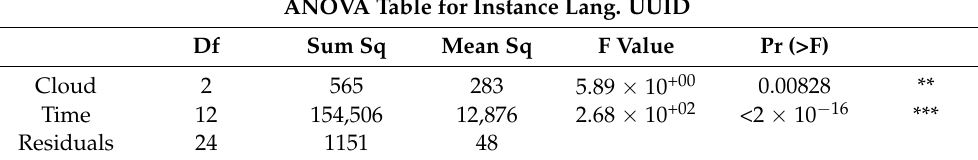
Table 4. ANOVA Table for instance Lang.